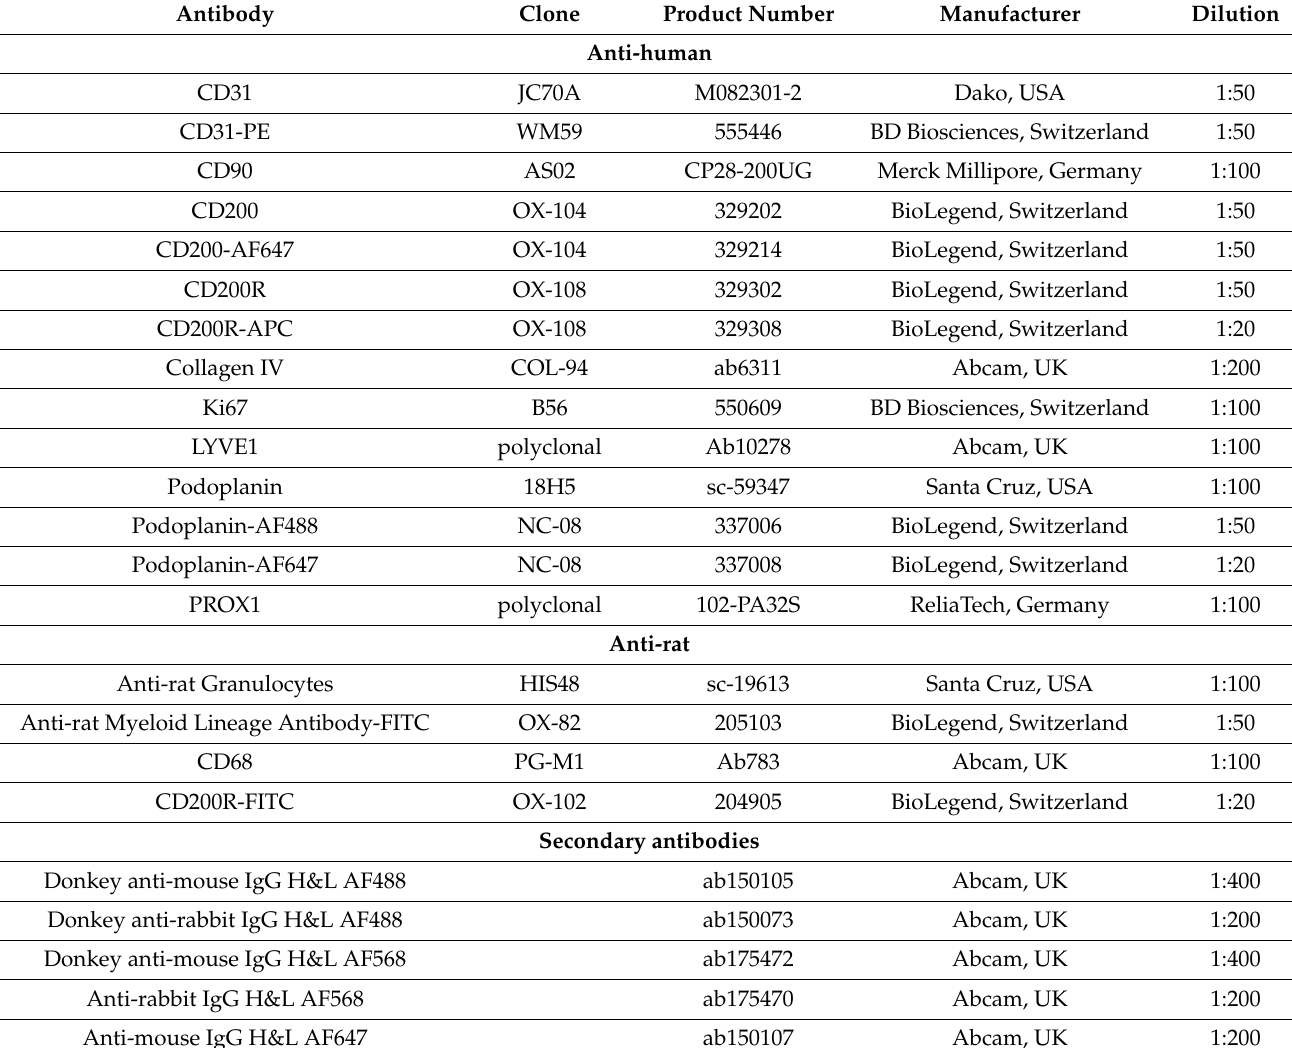
Table 2. Antibodies used in immunohistochemical